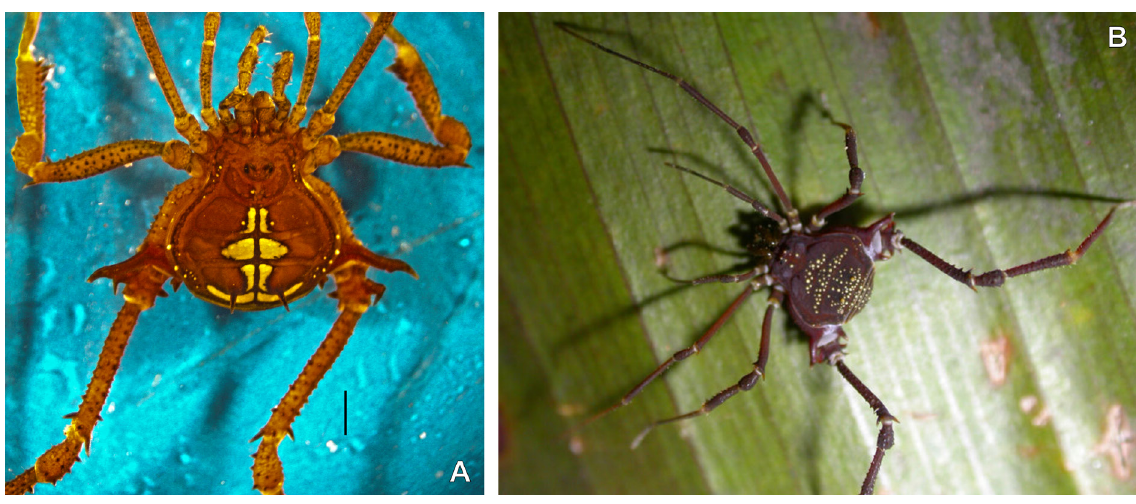
Fig. 10. Lacronia spp. A . L. camboriu Kury, 2003, ♂, holotype (MNRJ 4956 ꜝ ), specimen in alcohol, from Brazil, Santa Catarina, Balneário Camboriú. B . L. ceci Kury & Orrico, 2006, ♂, specimen in